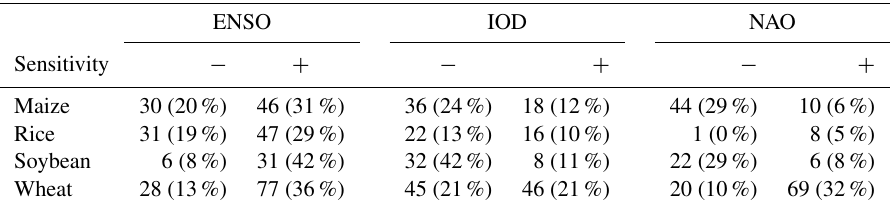
Table 3. Extent of significant sensitivity. Crop-specific harvested area (10 6 ha) extent (and percent of total crop-specific harvested area); actual crop yield shows statistically significant positive ( + ) or negative ( − ) sensitivity to ENSO, IOD, and NAO; i.e. there is a statistically significant (two-sided p value < 0.1) linear relationship between crop yield anomalies and the studied oscillations (see Methods). Harvested area extent showing significant anomalies is shown in Table